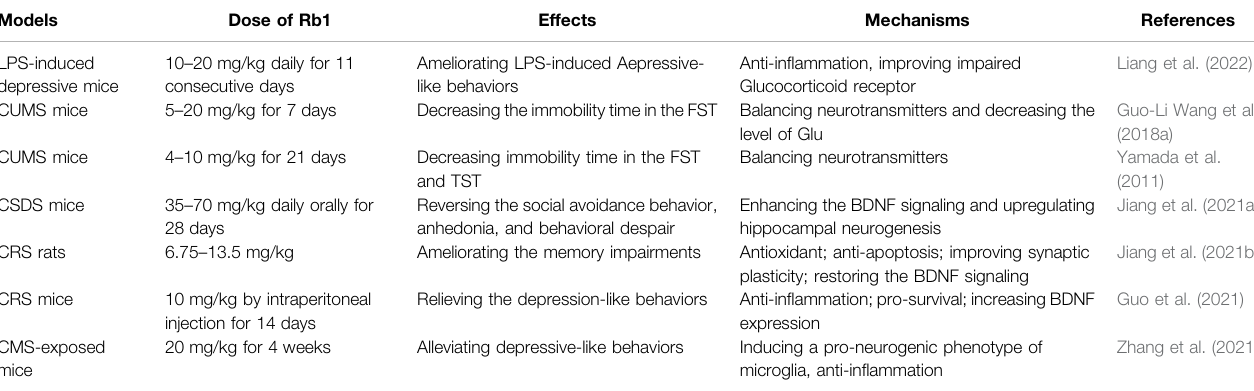
TABLE 4 | The neuroprotection of ginsenoside Rb1 in